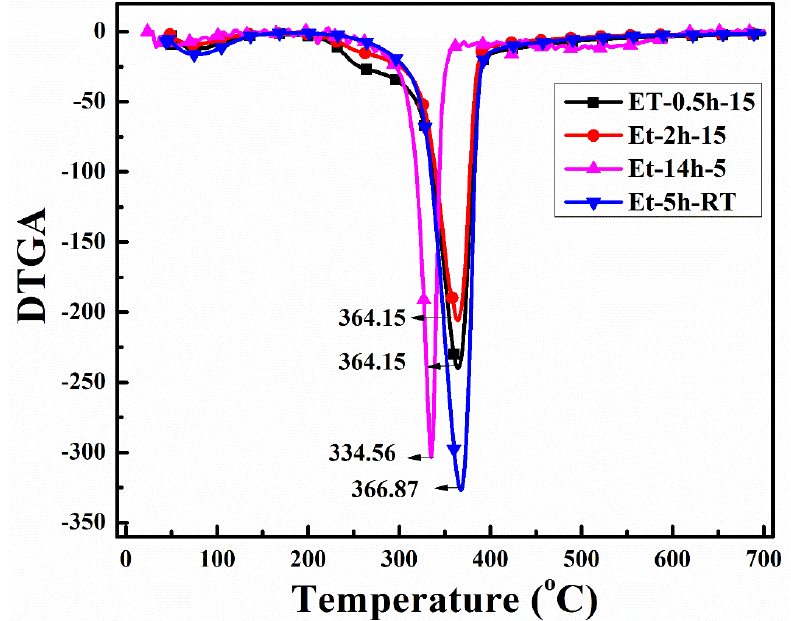
Figure 6. DTGA analysis curves of the coated fabrics obtained under various conditions.